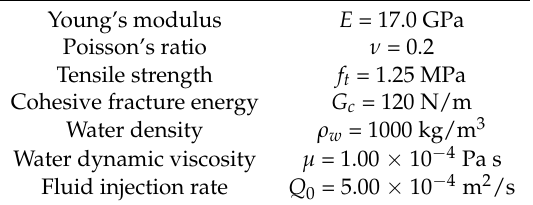
Figure 7. A hydraulic-driven fracture propagation in an imperious domain. A schematic representation of the Khristianovic–Geertsma–de Klerk (KGD) problem, the geometry, the boundary conditions, and the finite element mesh. Table 1. Parameters for the bulk material and the cohesive zone (from [22]).